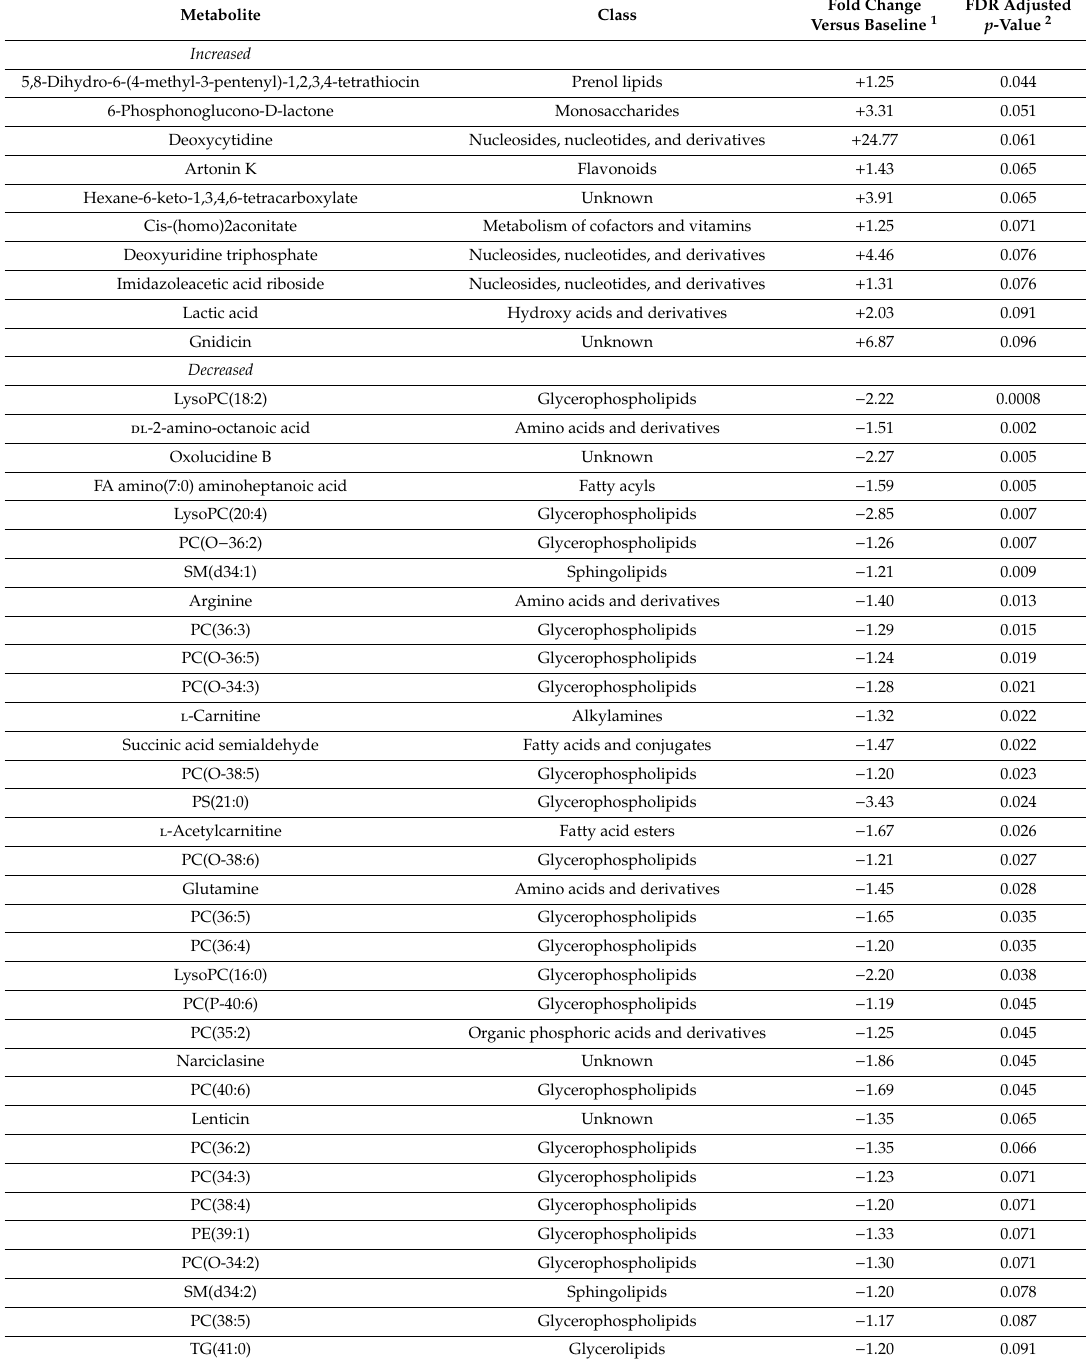
1 Baseline represents one hour before LPS administration. 2 p -values were calculated using paired t -tests with multiple-testing correction (Benjamini–Hochberg false discovery rate